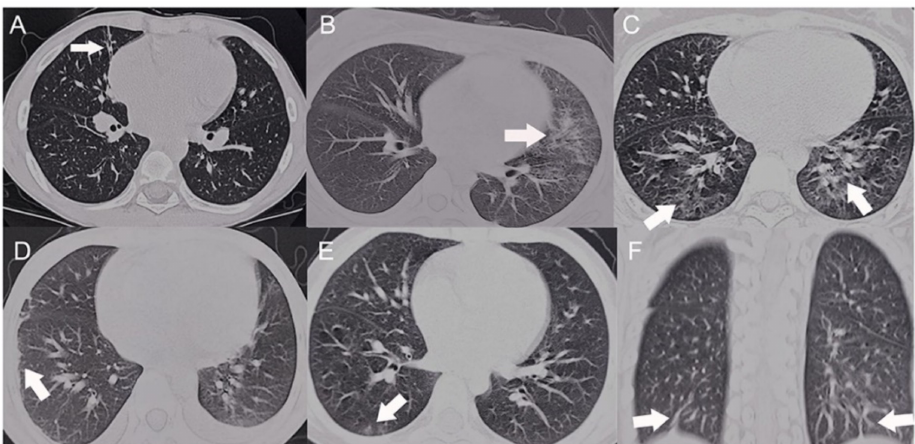
Figure 2. HRCT scans of the SLE patients with pulmonary involvement. Arrow indicate the shape of lung lesion of HRCT ( A ) Fibrotic streak. ( B ) Reticular pattern. ( C ) Mosaic perfusion. ( D ) Pleural thickening. ( E ) Ground glass opacity. ( F ) Subpleural interlobular septal thickening (The CC-BY Creative Commons attribution license, Dai G, Li L, Wang T, Jiang W, Ma J, Yan Y, Chen Z. Pulmonary Involvement in Children With Systemic Lupus Erythematosus. Front Pediatr. 2021 Feb 2; 8:617137. doi: 10.3389/fped.2020.617137. PMID: 33604317; PMCID: PMC7884320)